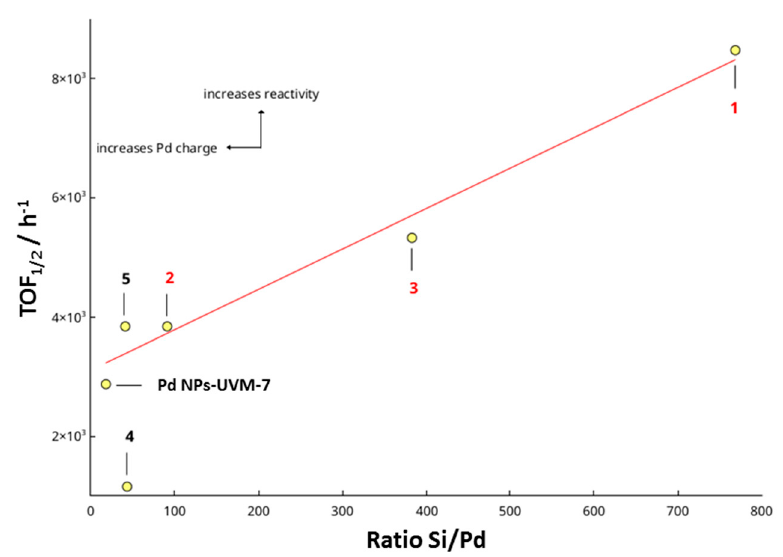
Figure 8. Correlation diagram between TOF 1 / 2 and the Si / Pd ratio. Bold red labels correspond to silica PDA covered materials Pd NPs-UVM-7 / PDA- n prepared in separate steps ( n = 1 , 2 , 3 ); black bold labels correspond to one-pot produced materials (n = 4 , 5 ). Pd NPs-UVM-7 is the silica nude material taken as the reference.